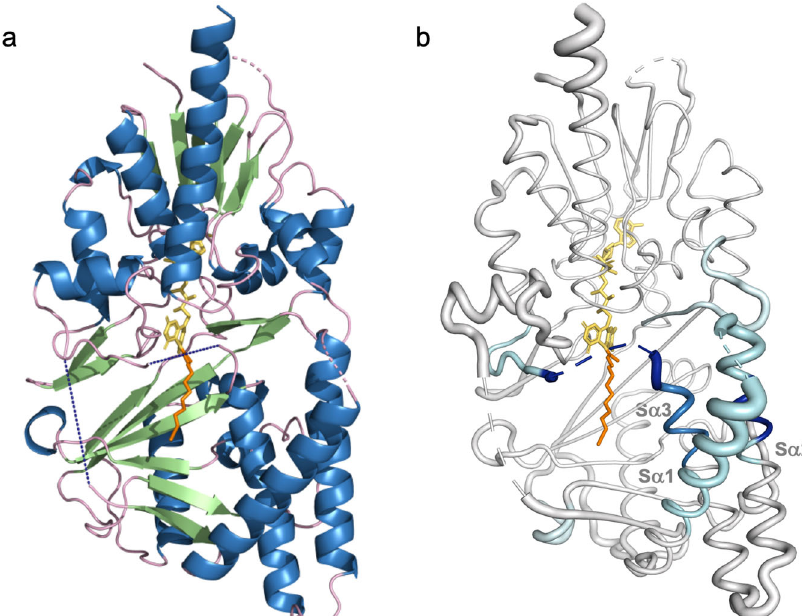
Fig. 3 Crystal structure of ehSMOX and HDX-MS. a Structure of ehSMOX with FAD in yellow sticks and MDL72527 in orange sticks. The blue dashed lines represent unde fi ned residues 81 – 97 (on the left) and 190 – 210 (in the center). b HDX-MS signature differences between apo hSMOX and hSMOX bound to MDL75257 overlaid onto a putty representation (areas with increased diameter correlate with higher B-factors; the dotted blue line represents residues 190 – 210) of hSMOX; decreased deuterium uptake upon MDL72527 binding, is depicted with a color spectrum from cyan to dark blue with increased